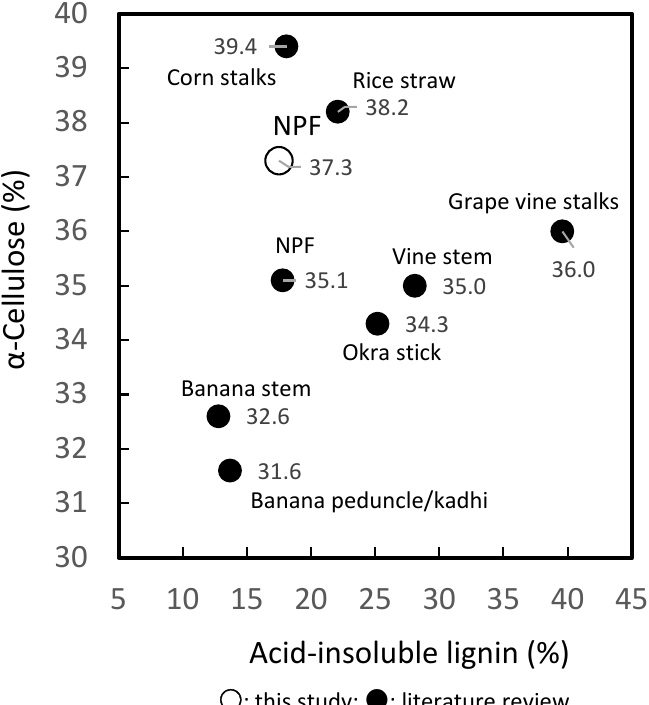
Figure 2. Comparison of α -cellulose and acid-insoluble lignin contents of Nypa fruticans fronds with those of other non-wood plants reported in the literature.